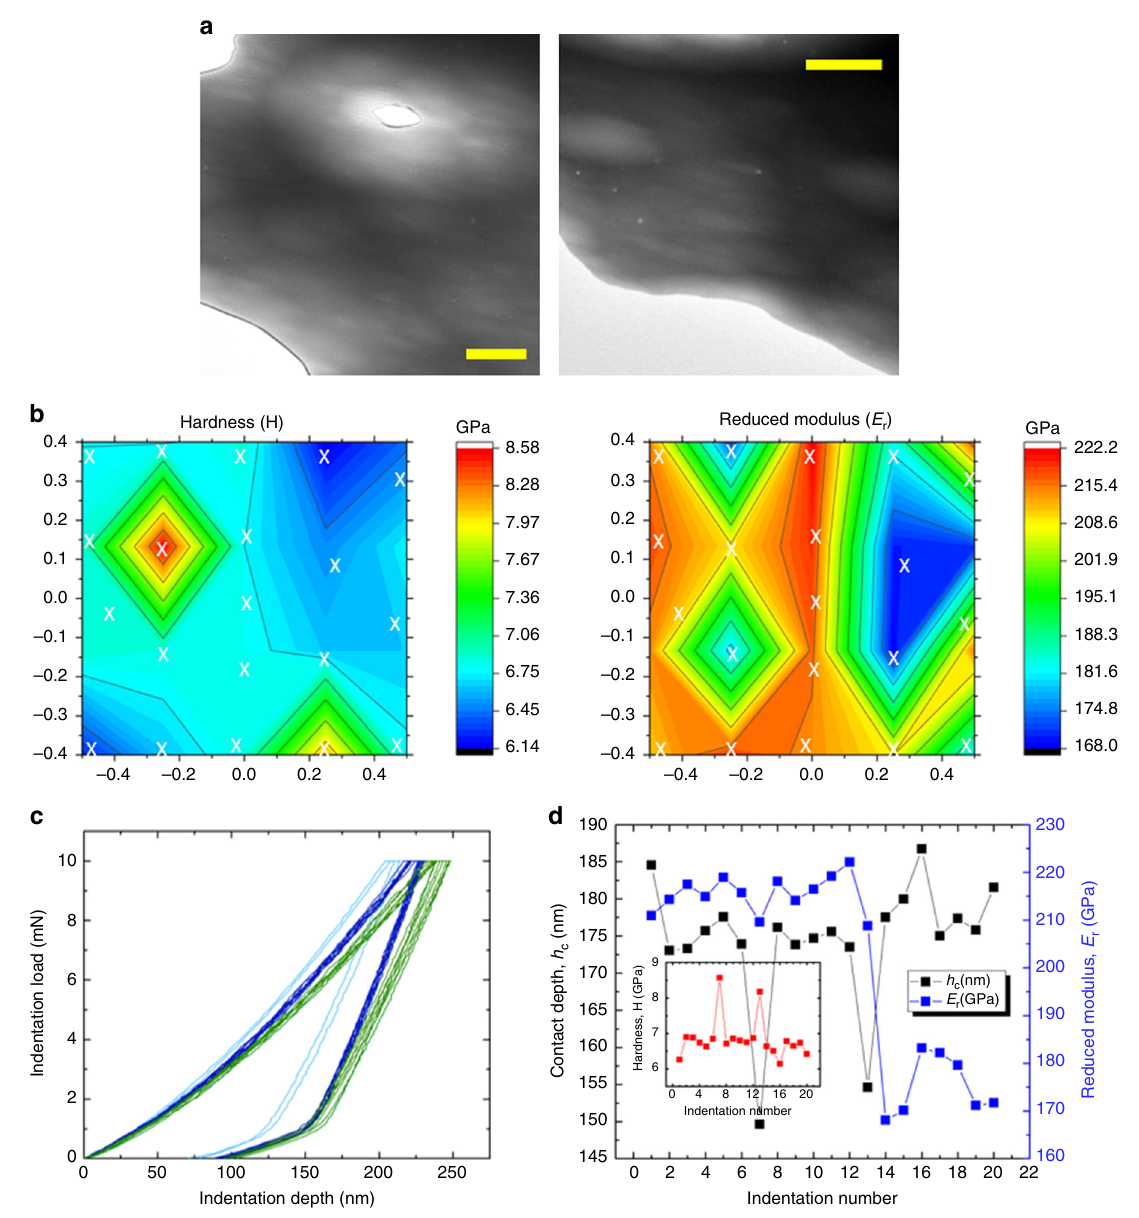
Fig. 3 Investigation of microscale heterogeneities. a Low-magni fi cation STEM images taken from the cross-section of the Fe 50 Ni 30 P 13 C 7 BMG. In order to eliminate any oxide layer and microcrystallinity generally forming on the surface during casting, our investigations were performed at the center region of the specimen (scale bars 2 µ m). b Hardness & Reduced Modulus contour plots of 1 mm-sized Fe-BMG disc (the distances are in mm). c Indentation load vs. indentation depth of the corresponding measurements. d The variations in the contact depth, reduced modulus, and hardness (inset) obtained from the nanoindentation